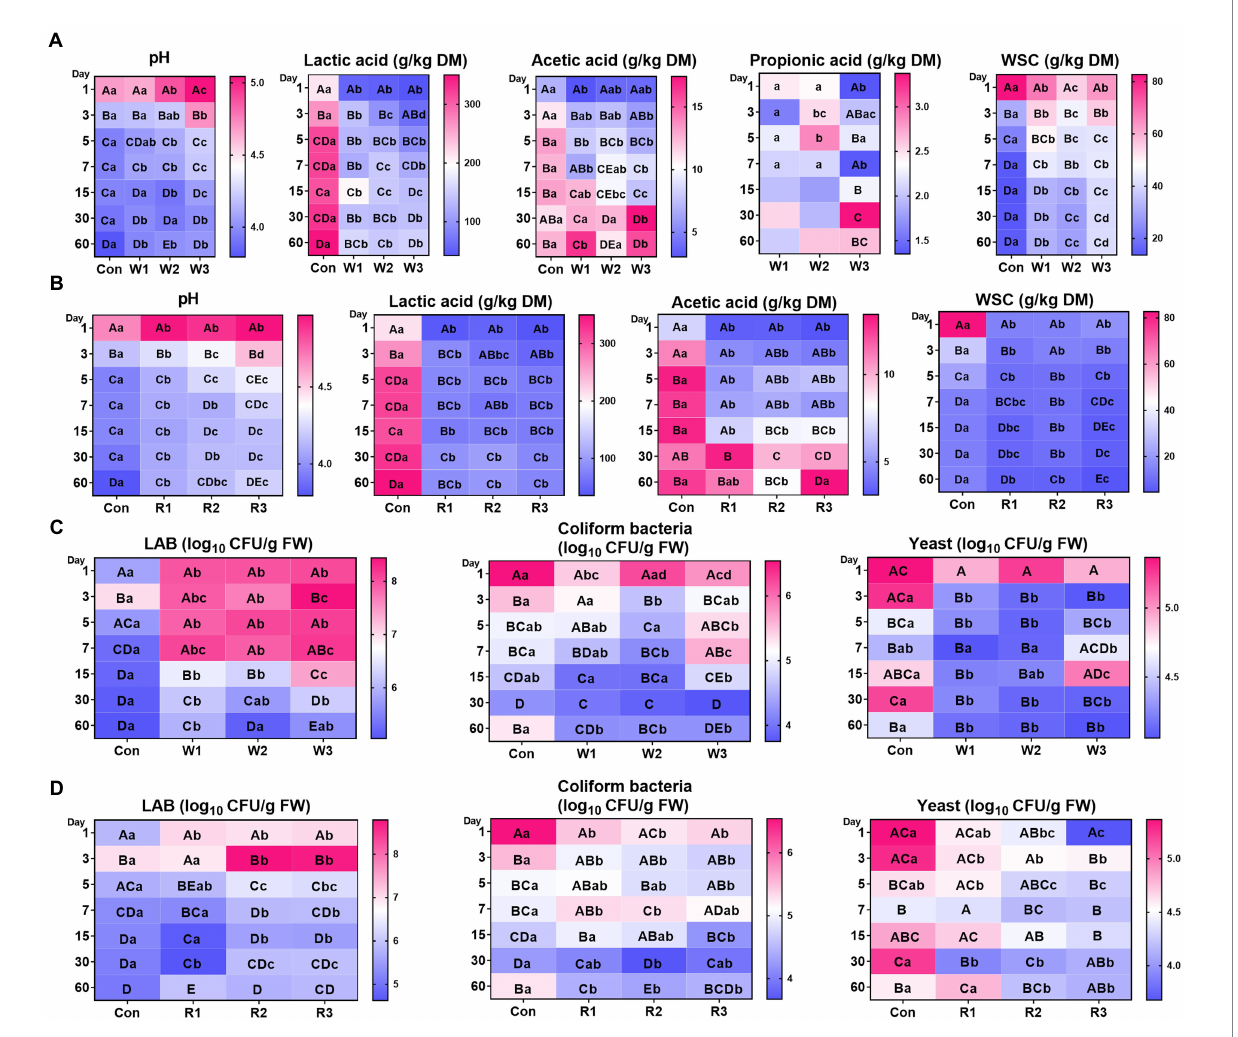
FIGURE 1 Fermentative characteristics (A,B) and culturable microbial profiles (C,D) during the anaerobic fermentation of Chinese cabbage waste. The control group (Con). Chinese cabbage waste was mixed with wheat bran at a mass ratio of 383:117 (W1), 353:147 (W2), and 323:177 (W3) or with rice bran at 387:113 (R1), 358:142 (R2), and 329:171 (R3), respectively; DM, dry matter; WSC, water-soluble carbohydrate; FW, fresh weight; LAB, lactic acid bacteria; CFU, colony-forming unit. The significant difference ( p < 0.05) between different days (column) in the same group is represented by the different capital letters; The significant difference ( p < 0.05) between different groups (row) on the same day is represented by the different lowercase